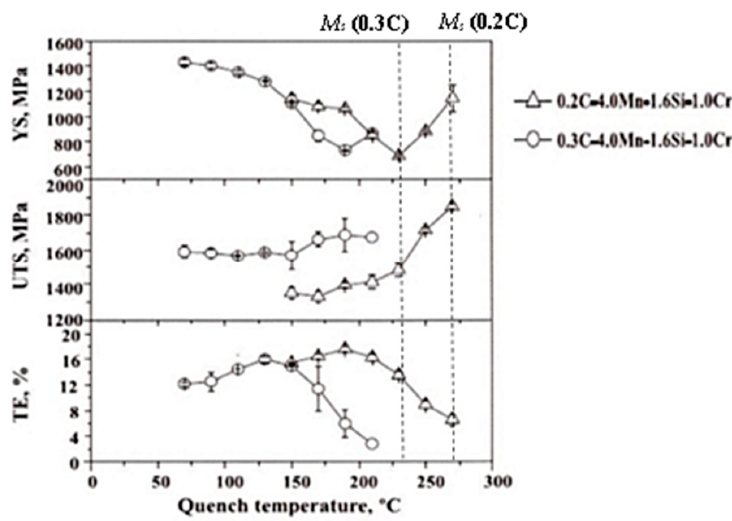
Figure 8. Quenching temperature dependences of yield stress (YS), tensile strength (UTS), and total elongation (TE) of 0.2C-4.0Mn-1.6Si-1.0Cr (0.2C) and 0.3C-4.0Mn-1.6Si-1.0Cr (0.3C) two-step Q&P steels partitioned at T P = 450 °C for 300 s after quenching [23]. M s s of the 0.2C and 0.3C Q&P steels are 273 and 235 °C, respectively. This figure is reprinted with permission from Elsevier, copyright 2022.